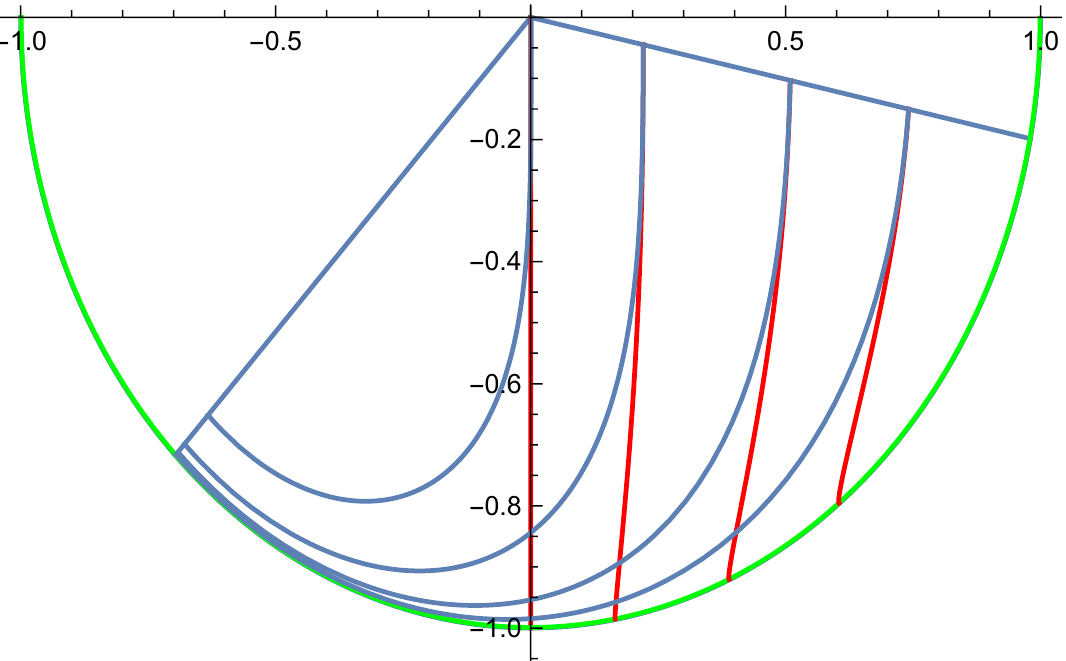
Figure 1. A sample of Dirichlet anchors from the bath brane for θ 1 = 0 . 8 , θ 2 = 0 . 2 . MHM surfaces are red, island surfaces are